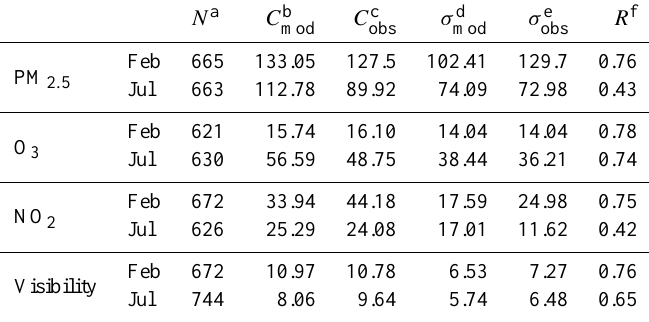
Table 2. Statistical summary of the comparisons of PM 2 . 5 , O 3 , NO 2 , and visibility between simulation and observations in Beijing.